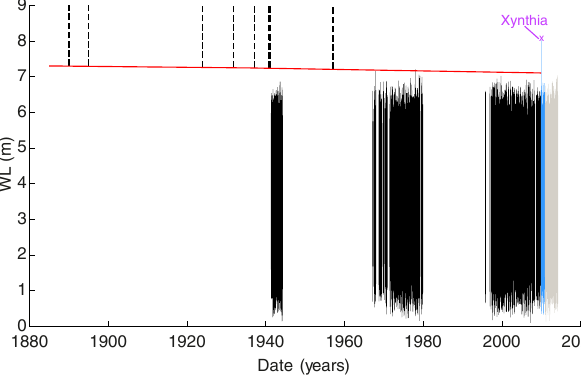
Figure 1. Study site and water level data localisation.